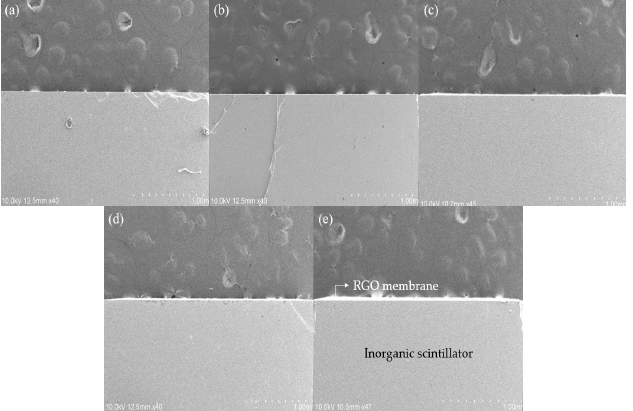
Figure 3. SEM micrographs of RGO membranes on the inorganic scintillators according to the number of coatings. ( a ) Uncoated, ( b ) coated 1 time, ( c ) coated 3 times, ( d ) coated 10 times, and ( e ) coated 20 times.